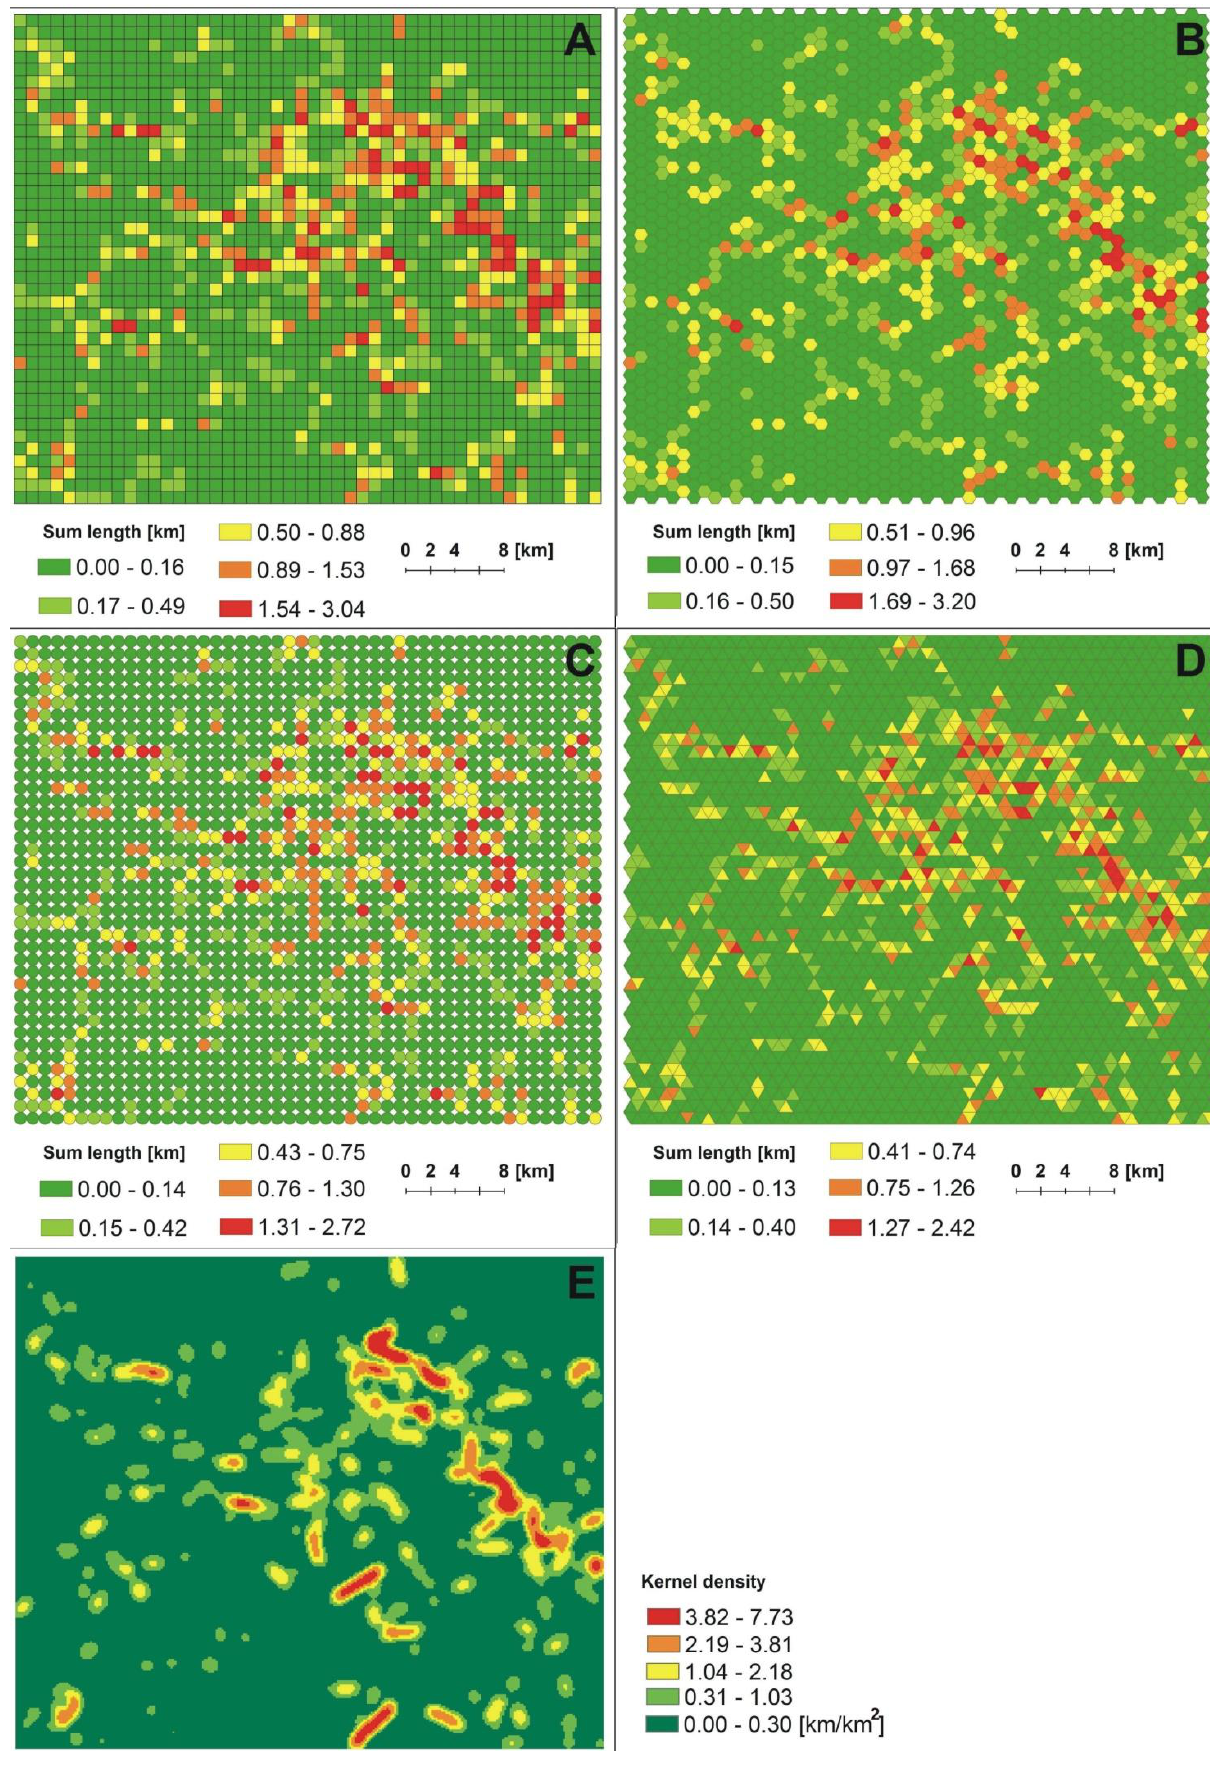
Fig. 7. Cartograms of line forms density in basic fields (1 km) A - squares, B - hexagons, C - circles, D - triangles and E - kernel